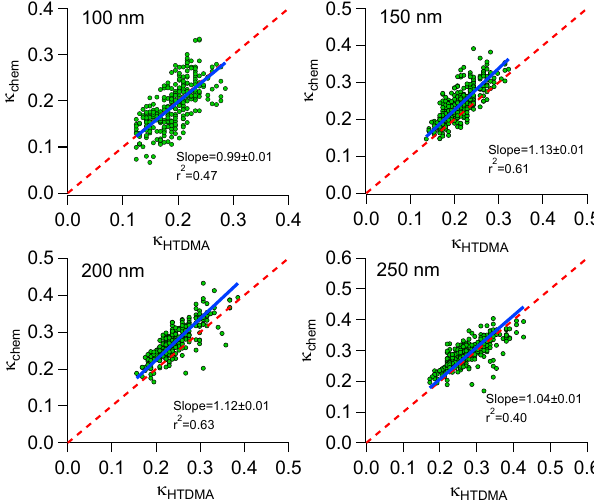
Fig. 7. Correlation between the hygroscopicity parameter for the Fig. 7: Correlation between the hygroscopicity parameter for the organic mass fraction,  org , and the 790 organic mass fraction, κ org , and the oxidation level of the organics oxidation level of the organics based on AMS speciation (O:C ratio). 791 based on AMS speciation (O:C ratio).